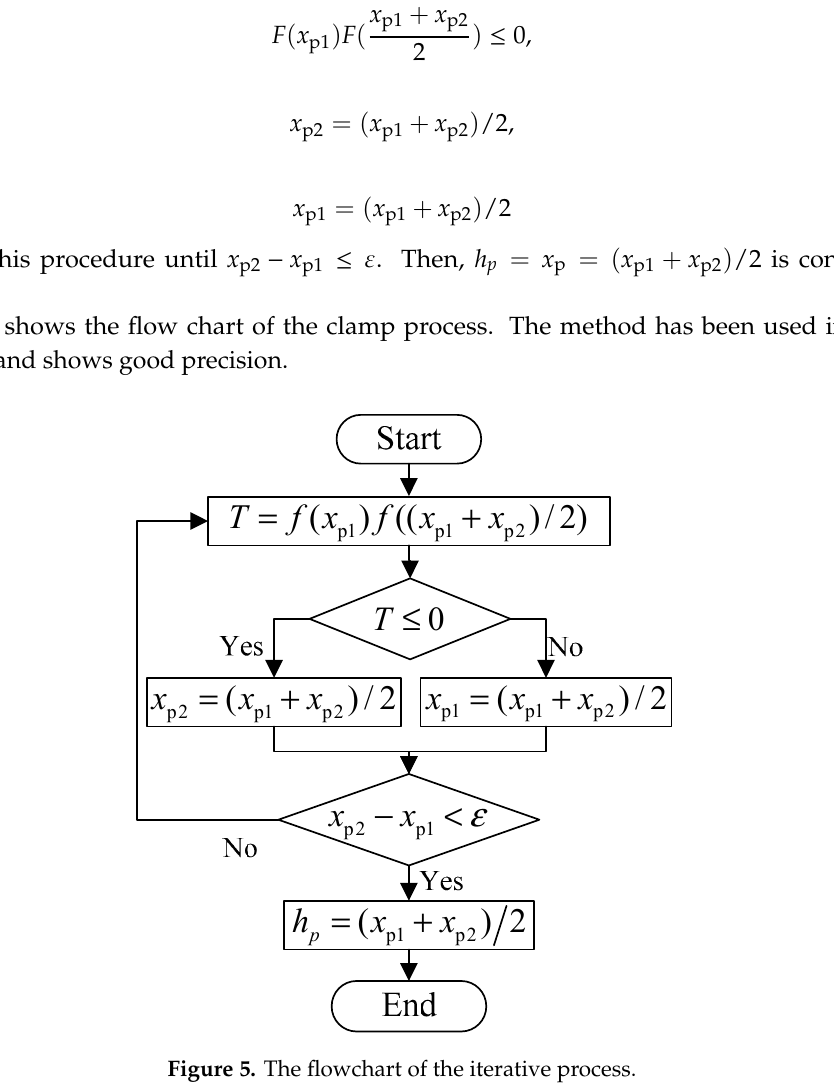
Figure 5. The flowchart of the iterative process.